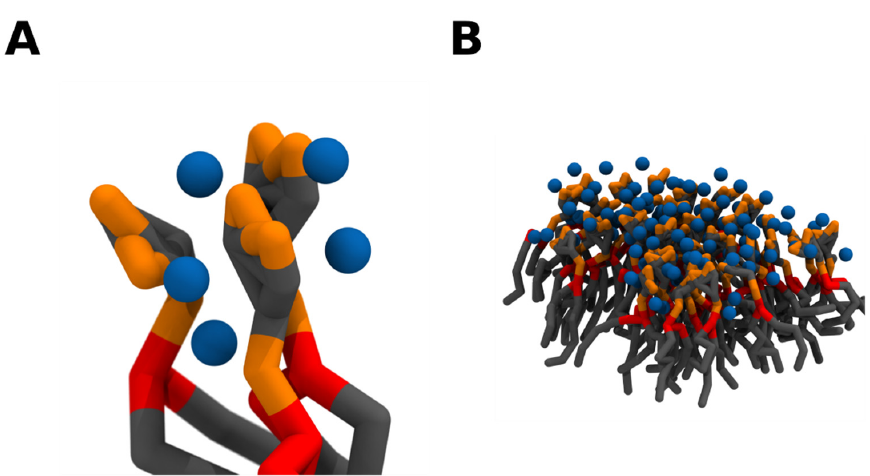
Figure 6. Crosslinking of PI(4,5)P 2 lipids induces the formation of PI(4,5)P 2 nanodomains. As a single divalent cation can bind up to 2 PI(4,5)P 2 lipids and each lipid can potentially bind 3 divalent cations, a network of electrostatic interactions can crosslink PI(4,5)P 2 lipids together ( A ). As the number of clustered lipids increases, PI(4,5)P 2 nanodomains are formed ( B ). Coarse grain beads representing the inositol headgroup and acyl-chains are colored in grey, the glycerol component in red, the phosphate groups in orange, and calcium in blue. Snapshots obtained from a simulation of a bilayer consisting of 95:5 mol ratio POPC: PI(4,5)P 2 in the presence of calcium in a 5:1 calcium to PI(4,5)P 2 ratio, using the martini 2.2 coarse-grained forcefield run in GROMACS2019. Images were modeled using VMD.